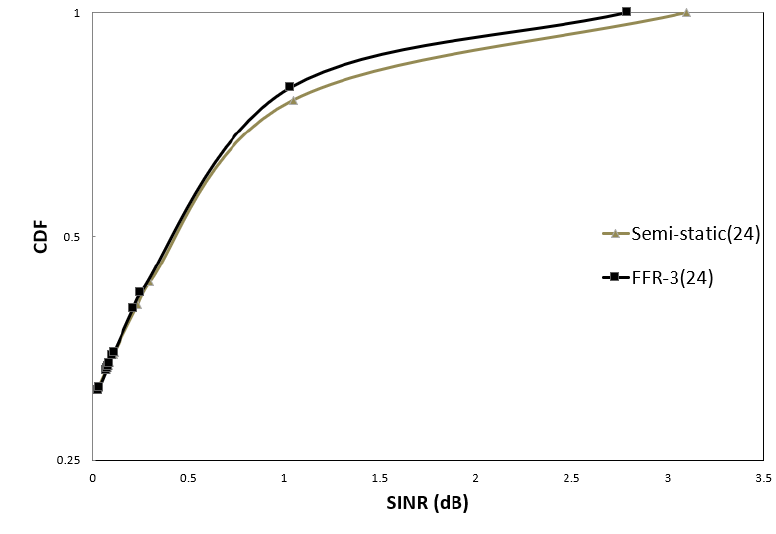
Figure 12. CDF of sensor SINR in cellular link (D2D Tx Power = 30